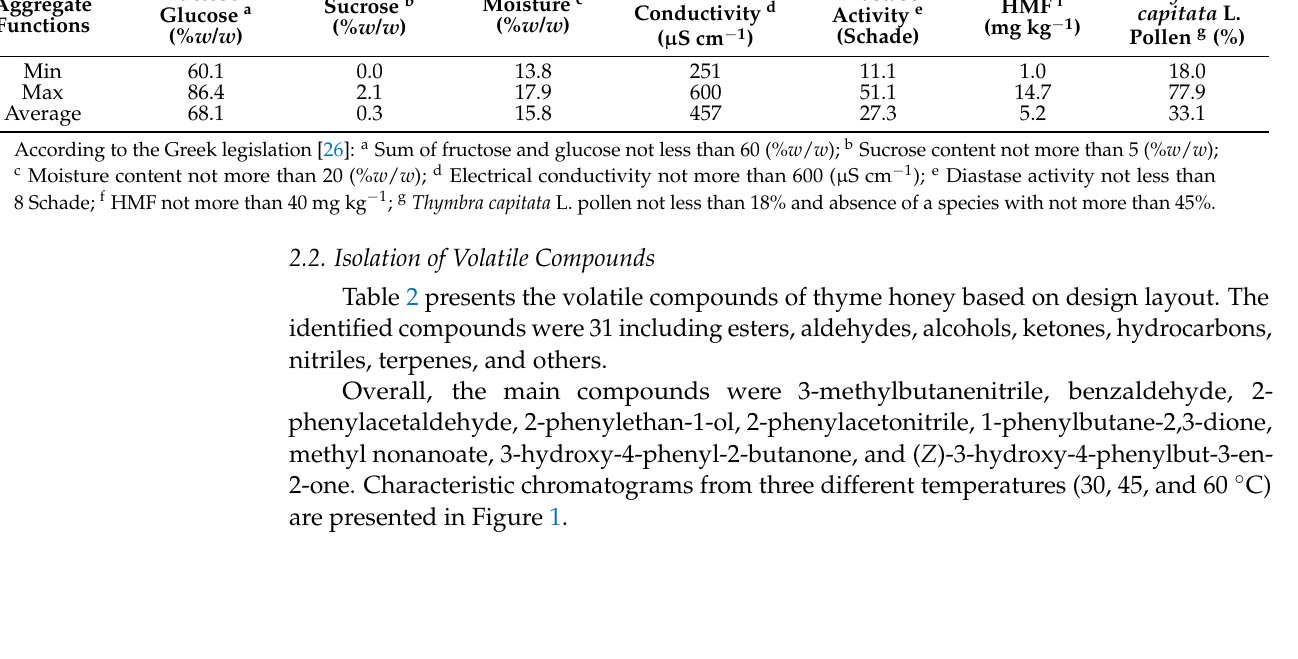
Table 1. Physicochemical and melissopalynological properties of samples used. Aggregate